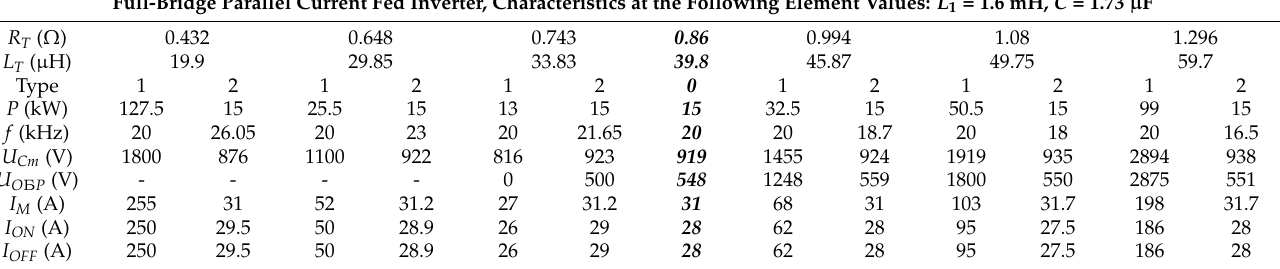
Table 3. Characteristics of the